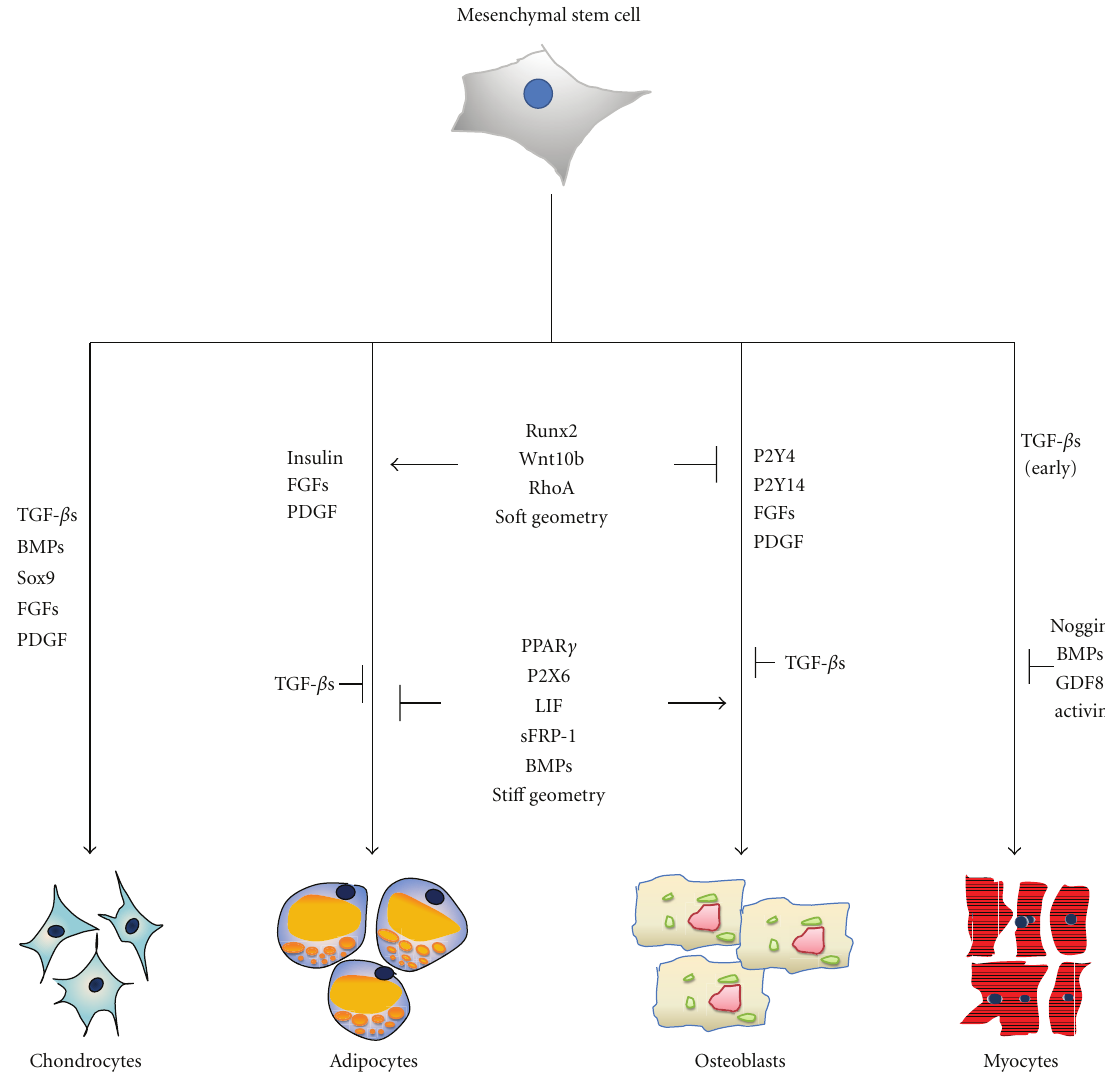
Figure 4: Key molecules regulating adipogenesis and osteogenesis in mesenchymal stem cells. Runx2, Wnt10b, RhoA, and soft geometry can induce osteogenesis while inhibiting adipogenesis. In contrast to this, PPAR γ , P2X6, LIF, sFRP-1, BMPs, as well as sti ff geometry can trigger adipogenesis while inhibiting osteogenesis. Next to these key molecules, FGFs and PDGF can induce both adipogenesis and osteogenesis. Insulin can induce adipogenesis, while P2Y4 and P2Y14 can induce osteogenesis and TGF- β s can inhibit both adipogenic and osteogenic di ff erentiation. The key molecules for the other major mesenchymal lineages are listed in the left-hand part of the figure for chondrogenesis and in the right-hand part for myogenesis. TGF- β s, BMPs, Sox9, FGFs, and PDGF are key triggers of chondrogenic di ff erentiation. TGF- β